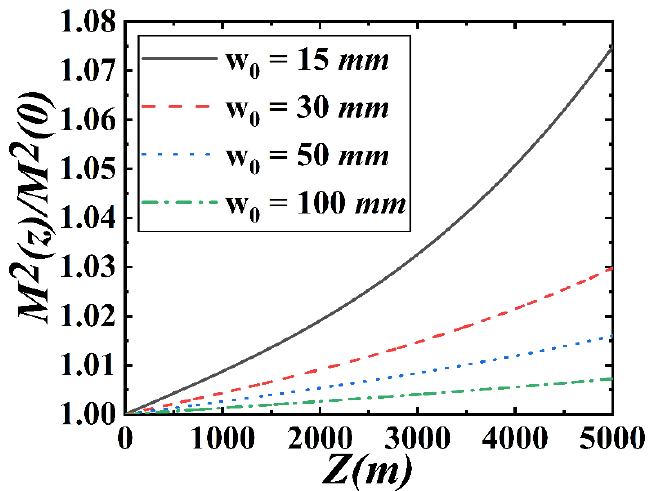
Figure 7. Dimensionless quantity M 2 ( z ) / M 2 ( 0 ) of a partially coherent Airy beam in non-Kolmogorov turbulence versus propagation distance for different w 0